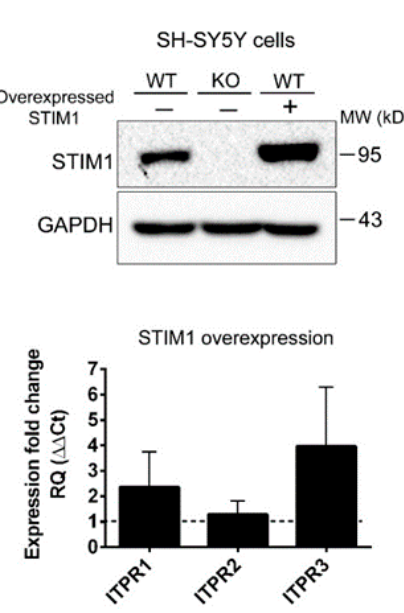
Figure A1. Top panel: Undifferentiated wild-type SH-SY5Y cells were stably transfected for the overexpression of STIM1 (lane 3), and the level of STIM1 was evaluated to compare with non-transfected wild-type cells (lane 1) and STIM1-KO cells (lane 2). GAPDH was used as a loading control of the immunoblot. Bottom panel: Bar chart depicts the relative quantification (RQ) of the ITPRs expression based on the double delta Ct method. This quantification indicates the expression fold change triggered by the overexpression of STIM1, i.e., ITPRs expression in wild-type cells overexpressing STIM1 compared with wild-type cells with endogenous STIM1 only. (***) Statistical significance p < 0.001.